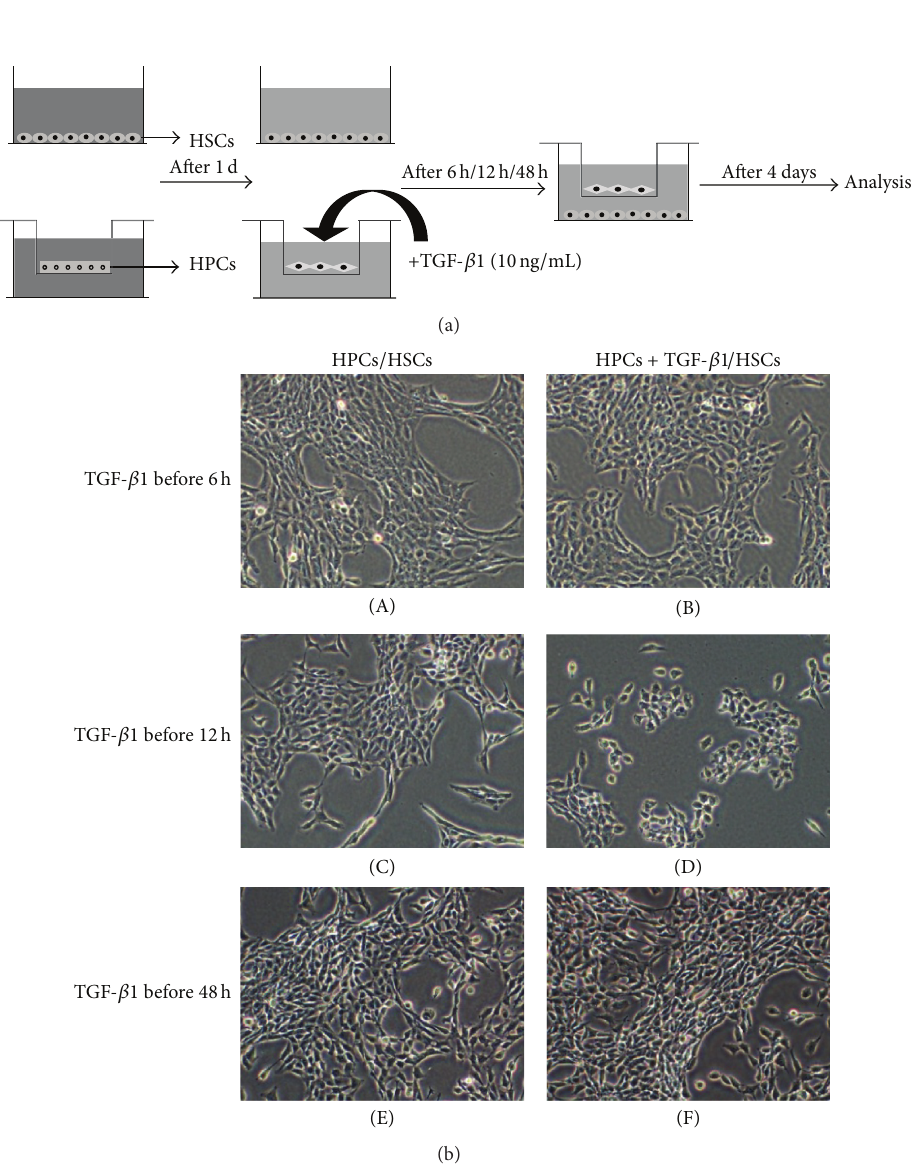
Figure 2: Influence of preexposure of HPCs to TGF- 𝛽 1 for different periods of time on the morphology of HPCs. Schematic of the experimental procedure (a). After exposure to TGF- 𝛽 1 for 12h, the HPCs were cocultured with HSCs. The HSCs lost their typical spindle shape, while the other groups did not experience any morphological changes